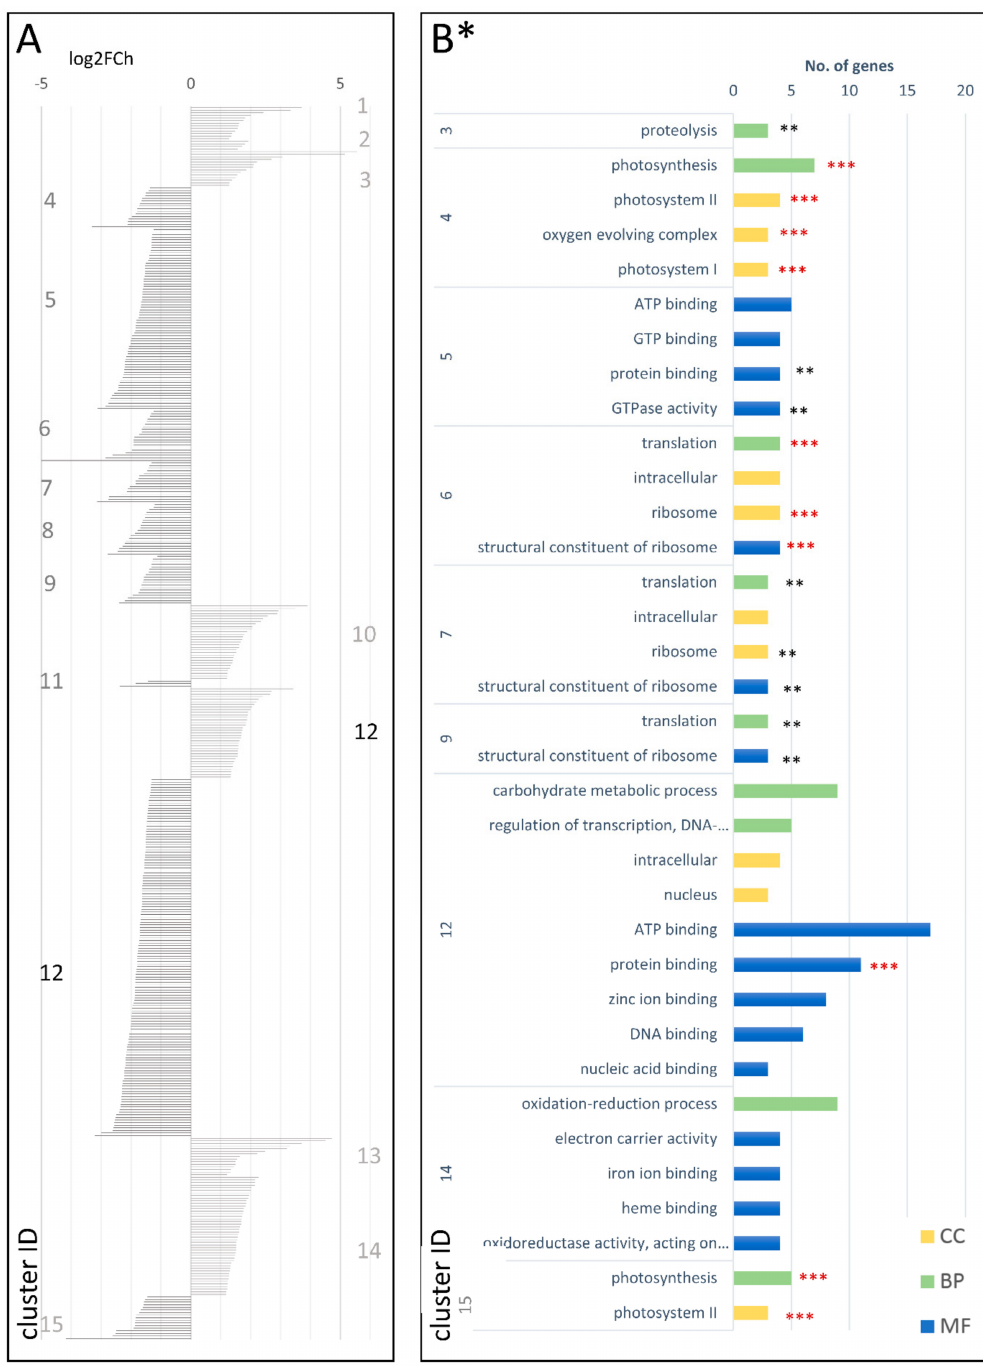
Figure 6. Clusters of DEGs in cultivated carrot (developing root vs. mature root; cDEG.2.3) showing log2FoldChange values ( A ) and GO enrichment results ( B ). CC—cellular component; BP—biological process; MF—molecular function; *—number of genes in set >2; **—adjusted p -value < 0.01; and ***—adjusted p -value <